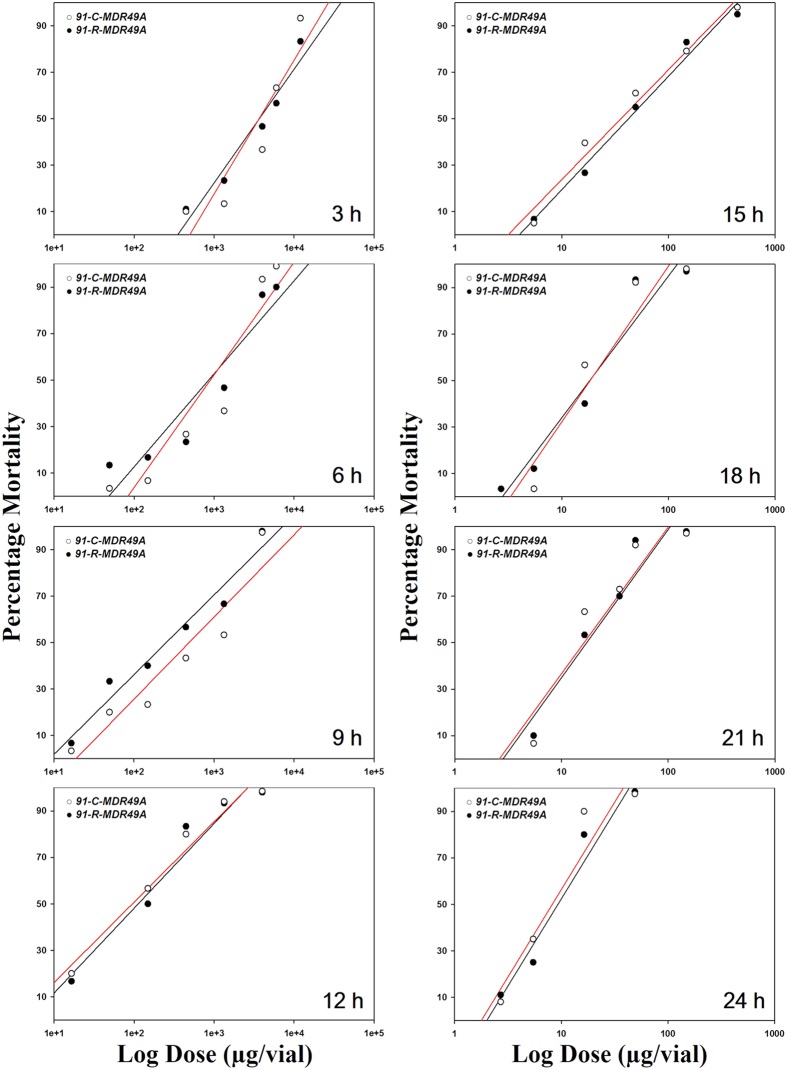
Dose-response curves for the transgenic strains, 91-C-MDR49A and 91-R-MDR49A.Log dose versus percent mortality response curves were determined at different time interval from 3 to 24 h following contact exposure to DDT (μg/vial), respectively. No significant differences between the two transgenic strains were observed at any time interval after DDT treatment.